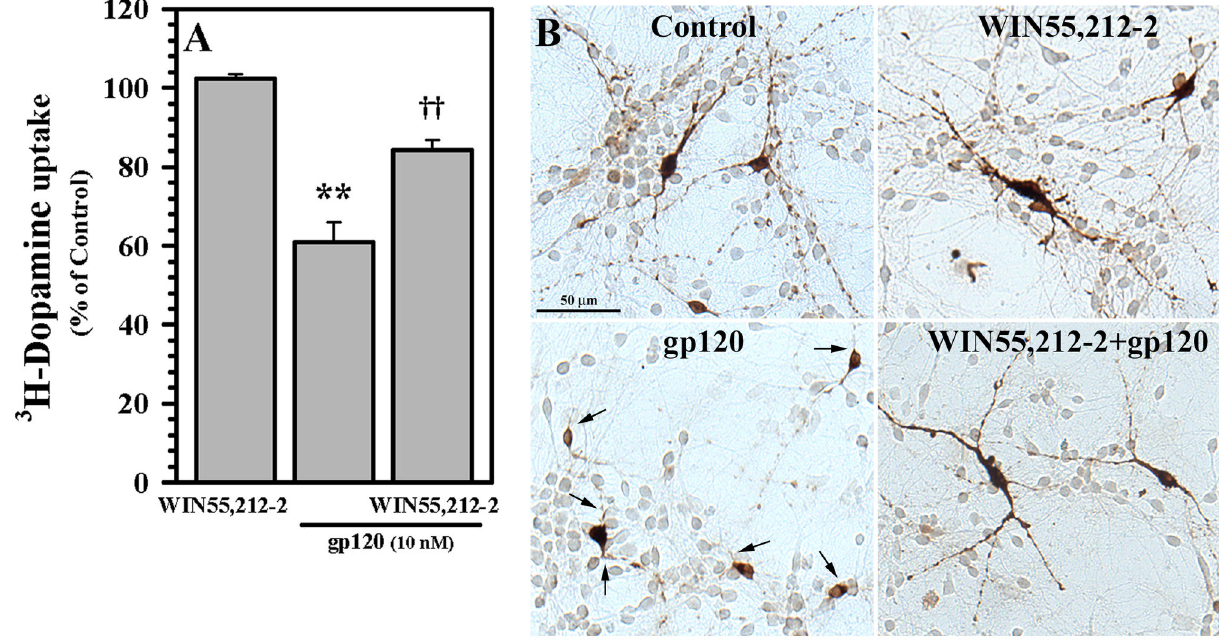
Figure 1. Blockade of gp120-induced dopaminergic neuron damage and suppression of dopamine transporter (DAT) activity by